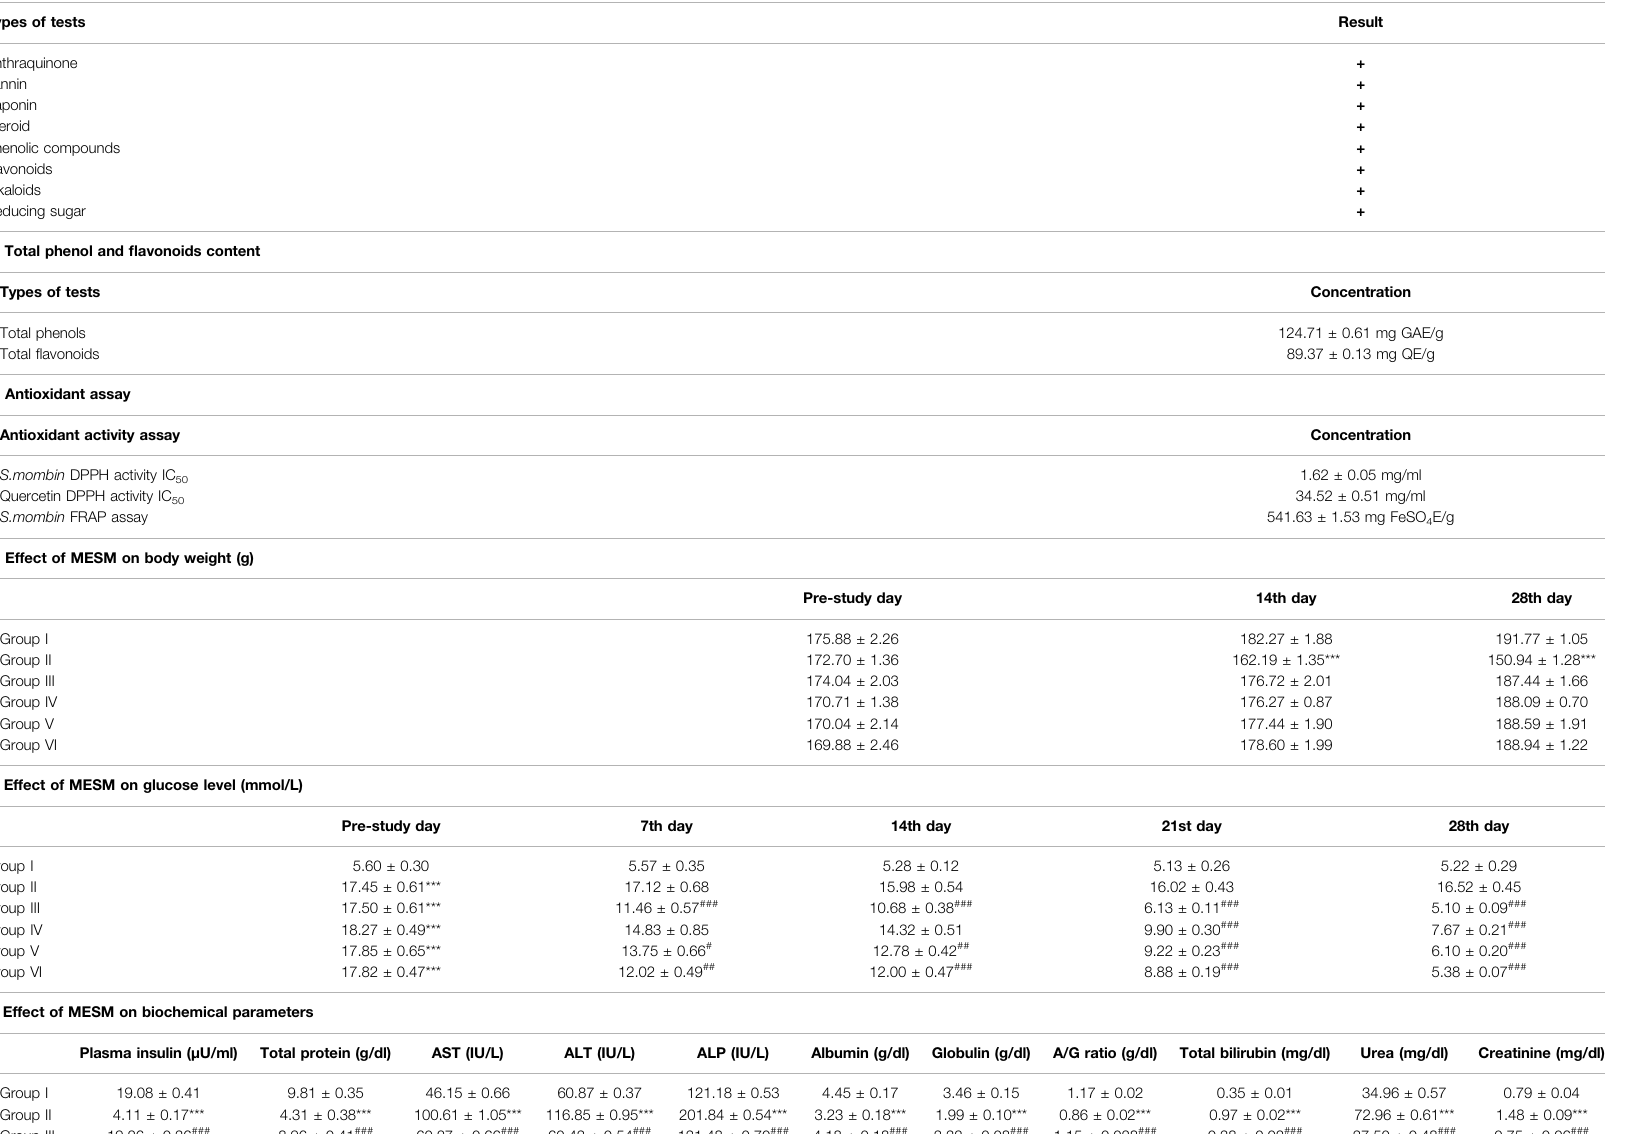
TABLE 1 | Effect of oral administration of methanolic extract of leaves of Spondias mombin (MESM) on sprague dawley